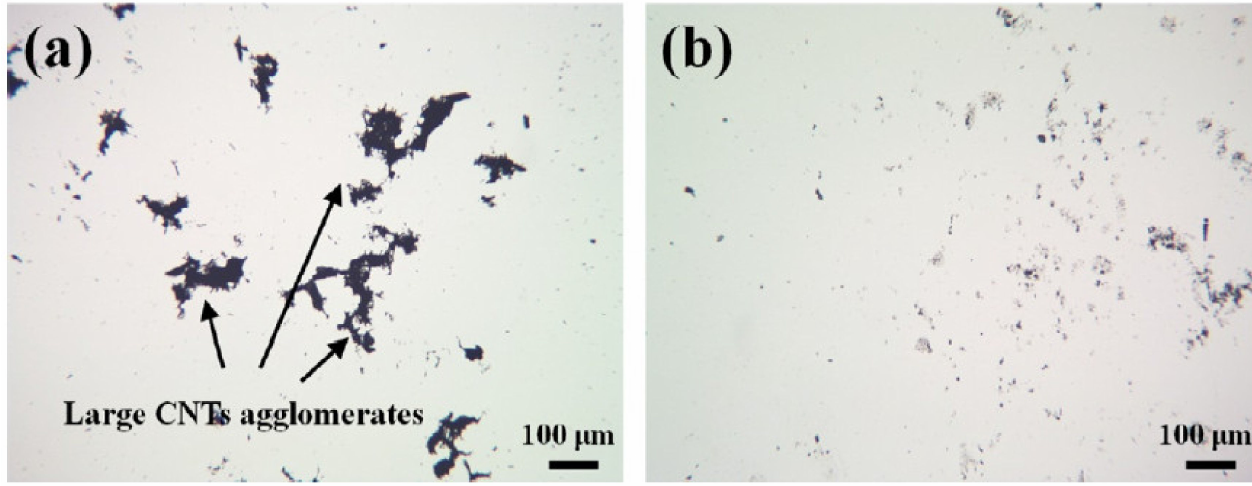
Figure 9. Example of light microscopy for monitoring the agglomerate size: ( a ) large agglomerates of MWCNT after sonication with 25 J/mL; ( b ) small agglomerates after sonication with 400 J/mL